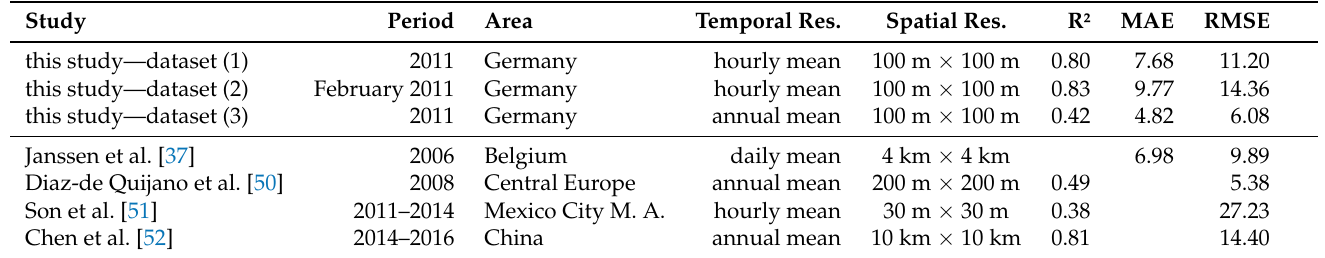
Table 5. Summary of the model results from similar studies with their respective study period and area plus their spatial–temporal resolution (Res.) (MAE and RMSE in µgm − 3 ). Period Area Temporal Res. Spatial Res. R² MAE